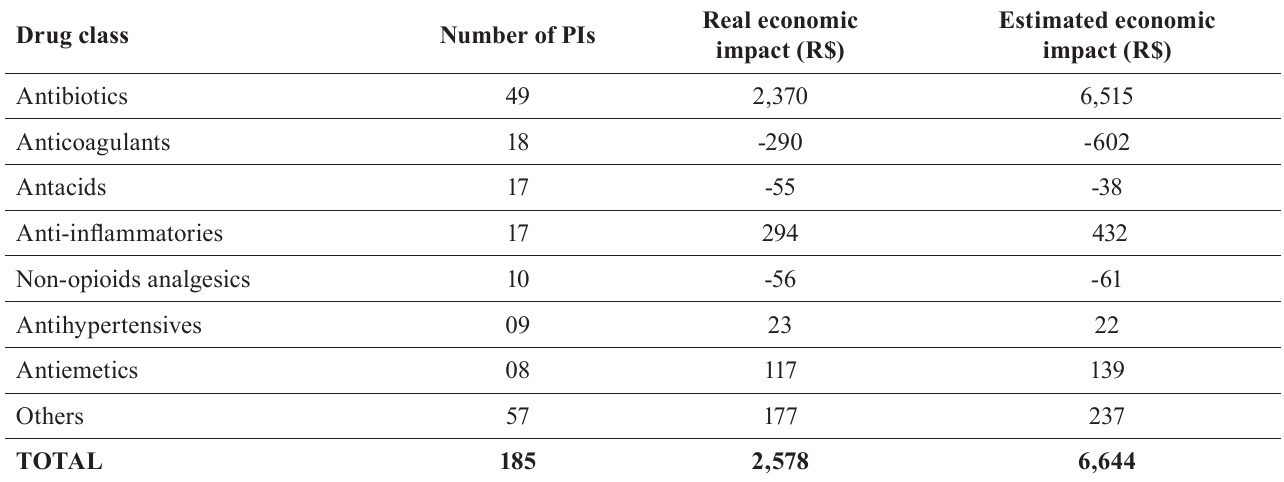
TABLE I - E conomic impact analysis by drug class